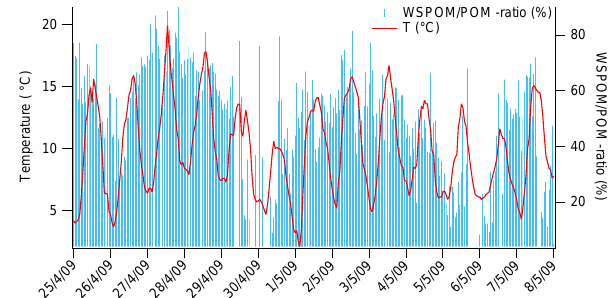
Fig. 6. Time-series of WSPOM/POM-ratio and temperature from 25 April to 8 May 2009.